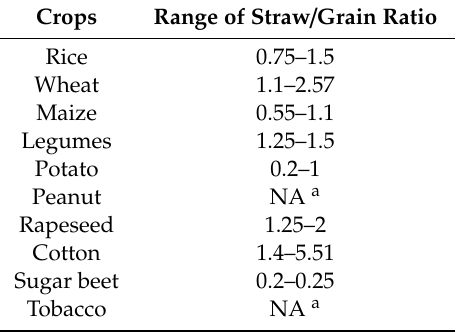
Table A3. Range of straw / grain ratio